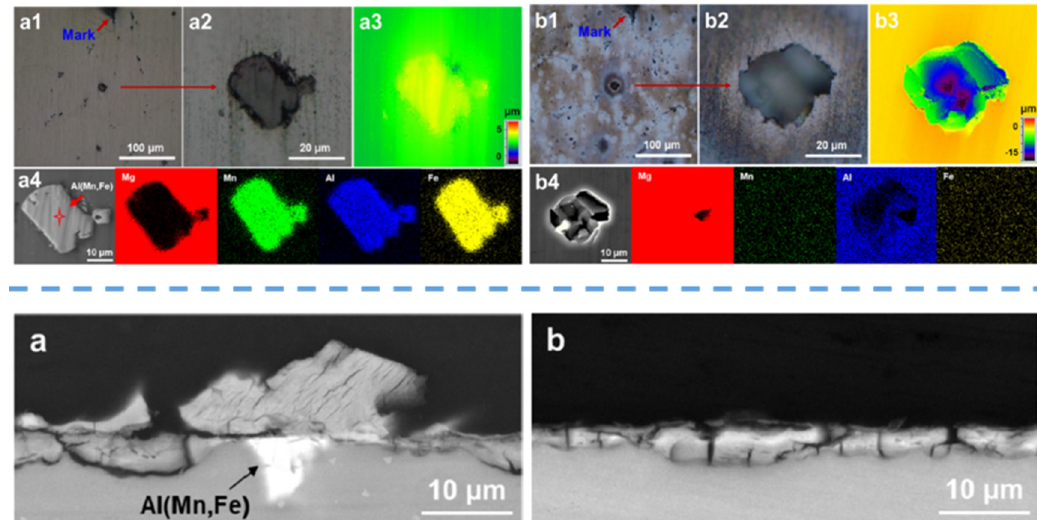
Figure 7. ( Top ) Surface morphology of Mg alloy AZ91 and the EDS results of the Al x (Mn,Fe) y phase ( a1 – a4 ) before and ( b1 – b4 ) after the pre-treatment. ( Bottom ) Electron probe microanalysis technique (EPMA) mapping of the cross-section of phosphate conversion coating on the ( a ) untreated and ( b ) pre-treated AZ91. Reprinted from [110] with permission from Elsevier.